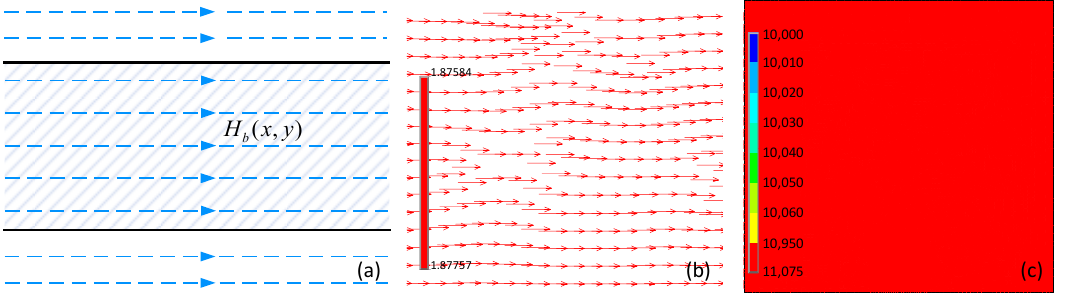
Figure 3. Dynamic magnetic action inside the material without any discontinuities, which is obtained by using the finite element method and magnetized by an encircling coil with a current density of 7 × 10 6 A/m 2 . ( a – c ) show the magnetic field lines, the magnetic vector, and the magnetic contour, respectively.